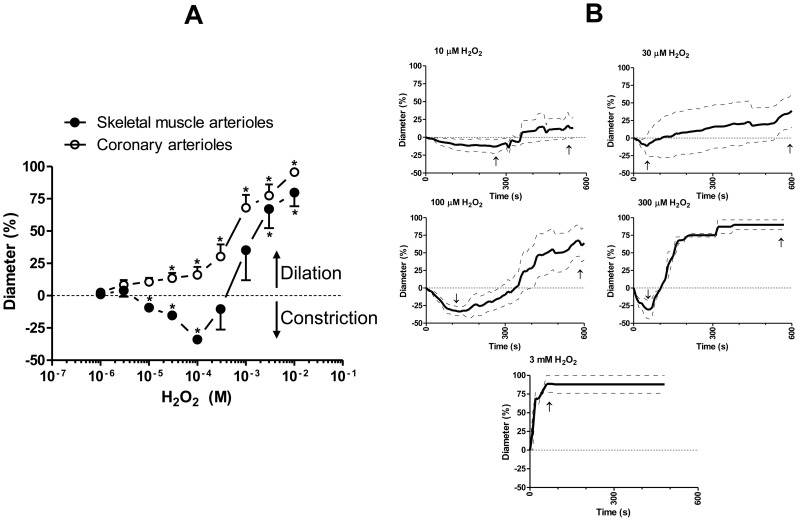
Effects of H2O2 on arterioles isolated from skeletal muscle and heart.H2O2 (1 µM–10 mM) was added to isolated, cannulated, skeletal muscle (initial diameter (id: 191±17 µm, n = 6 arterioles from 6 different animals) or coronary arterioles (id: 110±18 µm, n = 7 arterioles from 7 different animals) with intact endothelium. The arteriolar diameter was recorded and concentration-response (cumulative application) relationships were determined (panel A). Changes in relative arteriolar diameter are shown. Relative diameter changes during vasodilations were expressed as percentages of the difference between the maximum passive diameter (maximum dilation: 100%, determined in the absence of extracellular Ca2+) and initial diameter with positive values, while during constrictions they were expressed relative to the initial diameter (illustrated at 0% on the y axis) with negative values. Asterisks denote significant differences from the initial values. The kinetics of H2O2-evoked responses was studied in isolated skeletal muscle arterioles (panel B; means±SEM with solid and dashed lines, respectively). The effects of the indicated concentrations of H2O2 were recorded for 600 s in the continuous presence of H2O2 (n = 3–5 arterioles at each concentration from 11 different animals). The positions of maximum constrictions and dilations are illustrated by arrows.